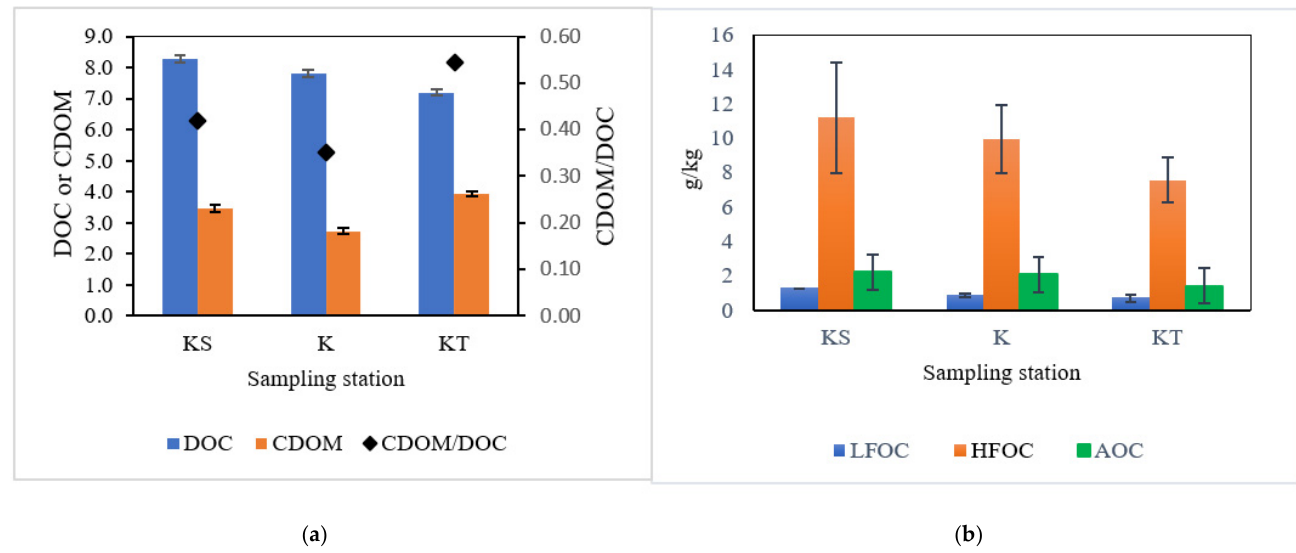
Figure 2. Variation of OC in bulk marine sediment, ( n = 9). ( a ) Concentration of DOC and CDOM, and the CDOM/DOC ratio. ( b ) Percentage of LFOC, HFOC and AOC in bulk marine sediment. Error bars indicate the standard deviation.